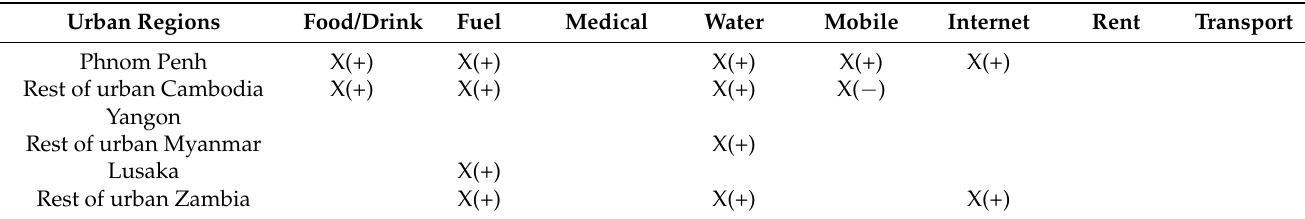
Table 8. Monthly expenditure items with a statistically significance difference between biomass-intensive and modern fuel-intensive households (X = significant, +/ − = increase/decrease in expenditure).